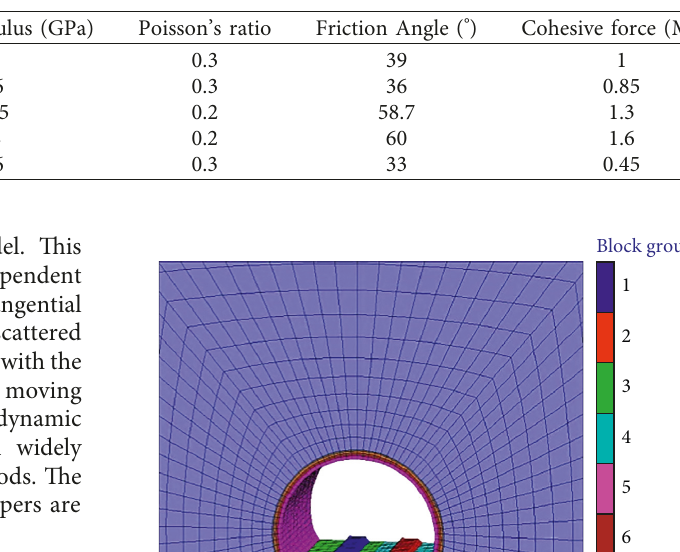
Figure 2: Schematic diagram for tensile and shear plastic flow zones in the Mohr–coulomb model. Table 2: Physical mechanics properties of model.